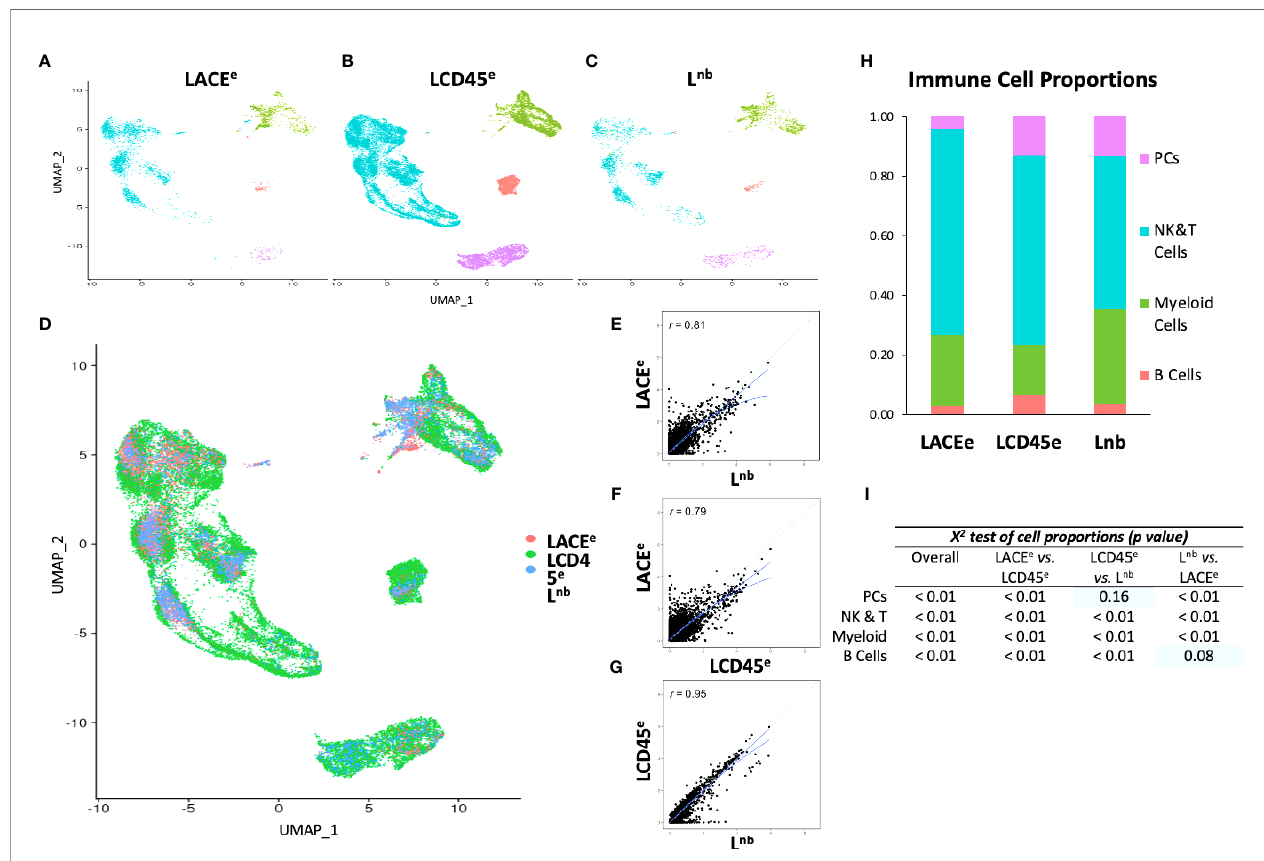
FIGURE 2 | Data visualization with clustering and gene expression correlation between datasets. (A – C) UMAP plots of individual studies. (D) Plot showing co- clustering of three single cell datasets. (E – G) Gene expression correlation plots with solid lines showing linear and quadratic regressions. Dashed line representing idealized relationship. (H) Bar graph representation of immune cell proportions of each individual dataset. (I) X 2 comparison showing signi fi cant differences in proportions of immune cell subpopulations. With pairwise analysis, most chi-squared values reached statistical signi fi cance except for plasma cells in LCD45 e versus L nb and for B Cells in L nb versus LACE e (indicated by blue